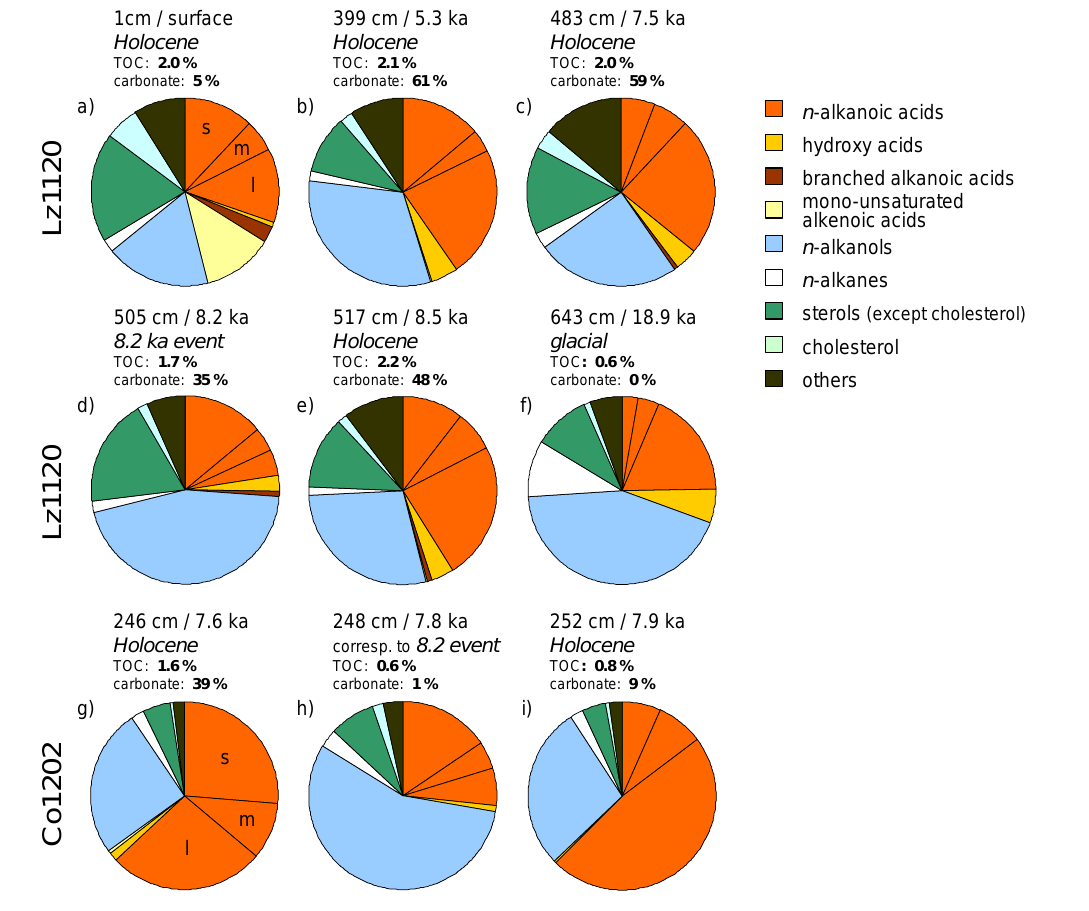
Fig. 3. Composition of total lipid extracts of samples from sites Lz1120 (a–f) and Co1202 (g–i) . The segments within the n -alkanoic acid signature represent (clockwise) short- (s), mid- (m) and long-chain (l) n -alkanoic acids. Note the considerably higher proportions of n -alkanoic acids at site Co1202 and the increased amounts of n -alkanols in samples from the 8.2ka event and the glacial. Labile unsaturated n -alkanoic acids are present in significant amounts in the surface sample,